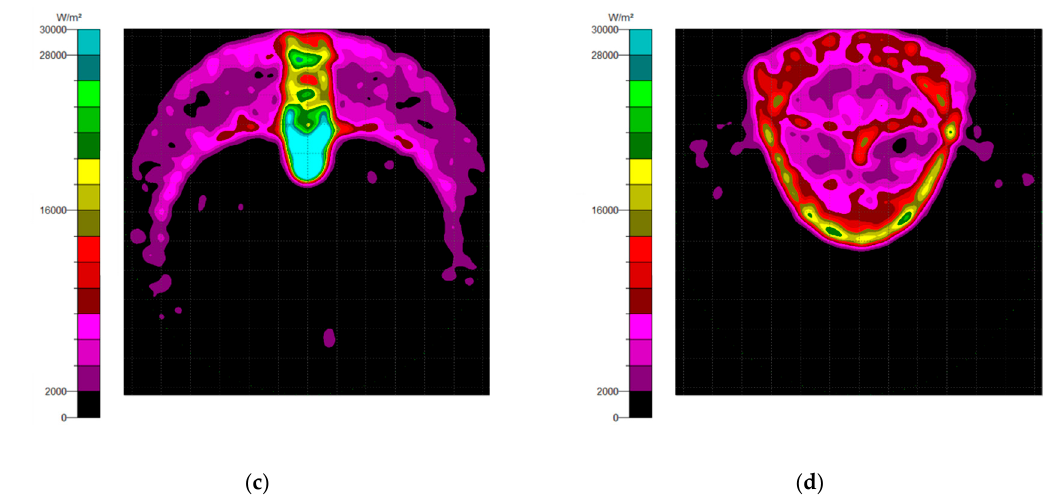
Figure 12. The irradiance distribution of the mirror-CPC with misalignment angles of ( a ) 0°, ( b ) 10°, ( c ) 20°, and ( d ) 30°.